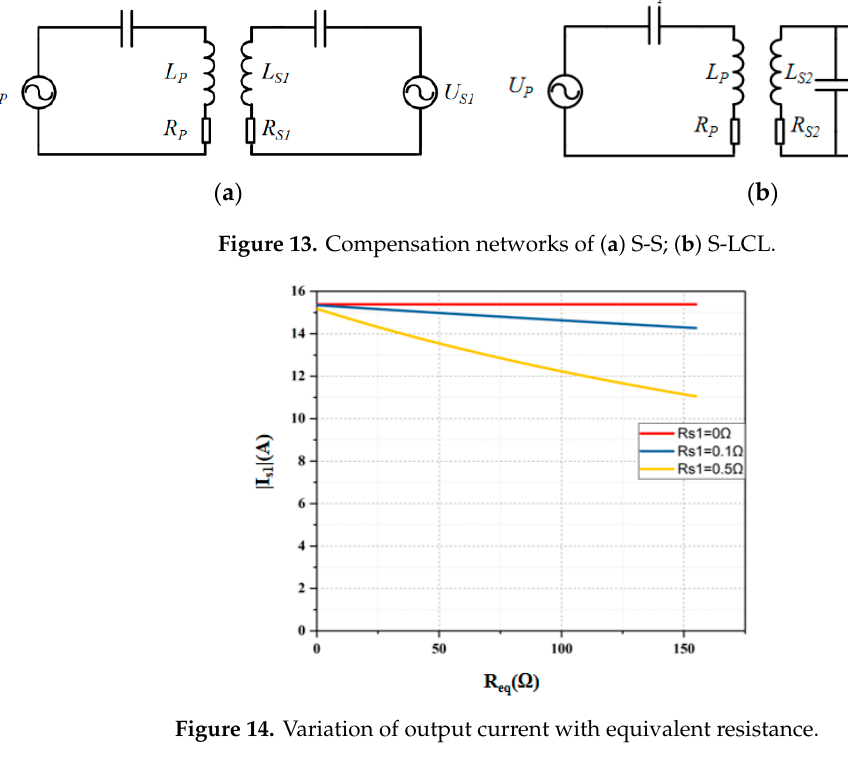
Figure 14. Variation of output current with equivalent resistance.